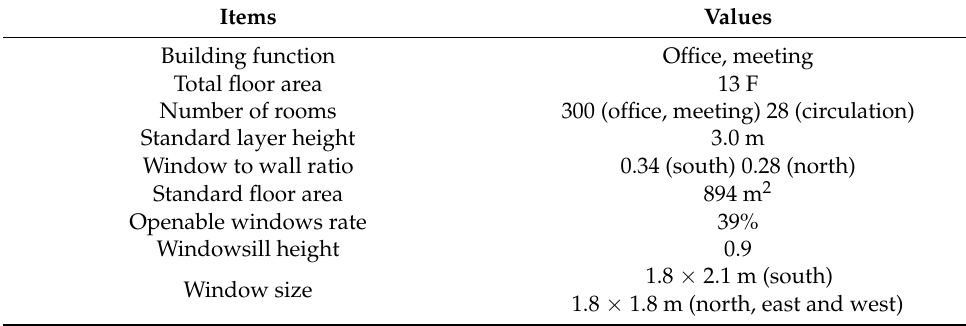
Figure 5. Details of the architectural design. Table 4. Building information.